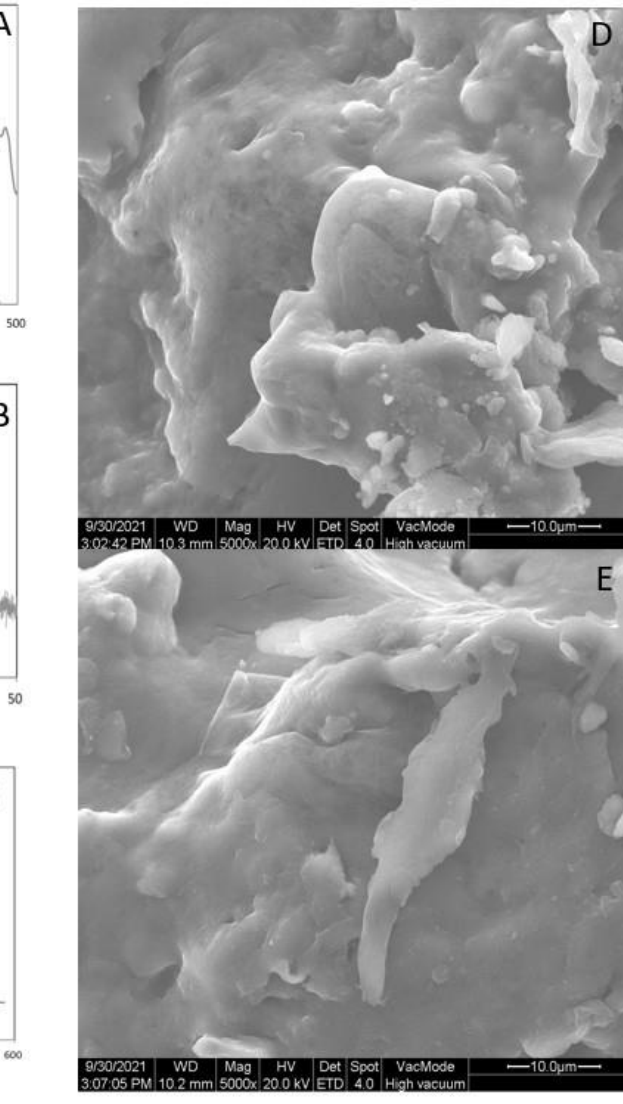
Figure 1. ( A ) FTIR spectra; ( B ) XRD patterns; ( C ) TGA analysis; ( D , E ) SEM of pectin.